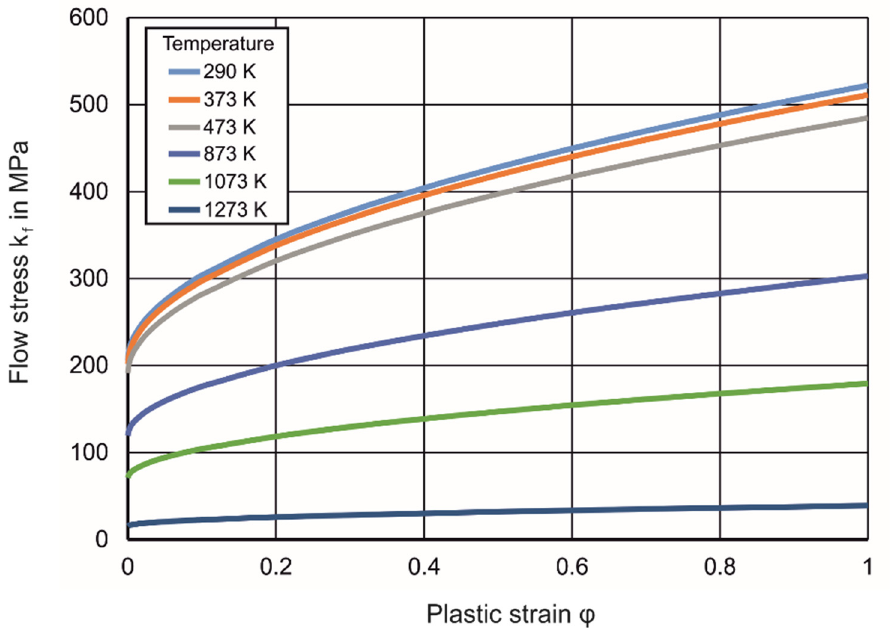
Figure 5. Temperature-dependent stress-plastic strain flow properties of CuCr1Zr from high-temperature tensile tests and extrapolation exponentially.